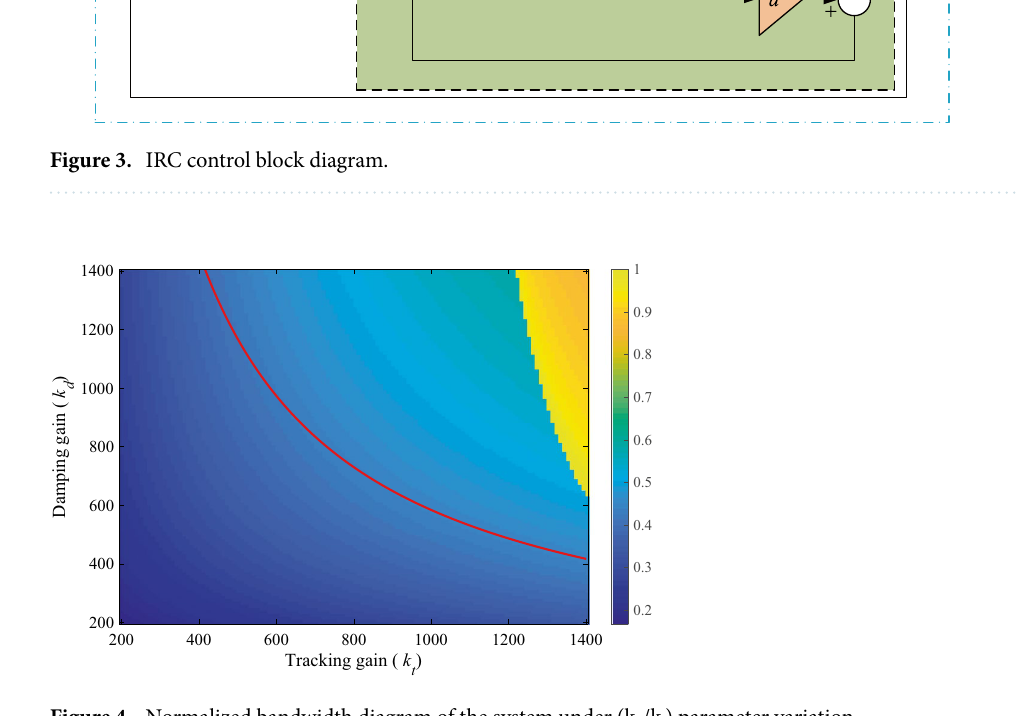
Figure 4. Normalized bandwidth diagram of the system under (k d /k t ) parameter